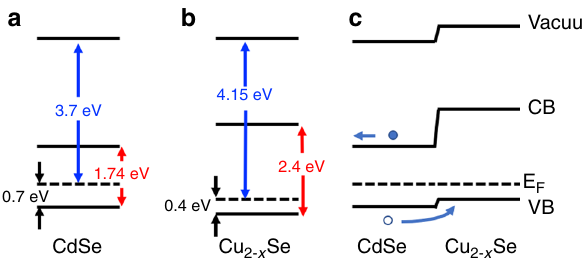
Fig. 5 Flat band schemes. Energy levels of the CdSe ( a ), Cu 2 − x Se ( b ), and of the heterojunction ( c ) as obtained from ultraviolet photoelectron spectroscopy (UPS) data (see Supplementary Figure 8) and the bulk band gap values. Energies of Fermi level to vacuum are stated in blue, valence band to Fermi level in black, and the band gap in red color. The full and hollow circles in c represent the photoexcited electrons and holes, respectively, and the arrows indicate the charge separation induced by